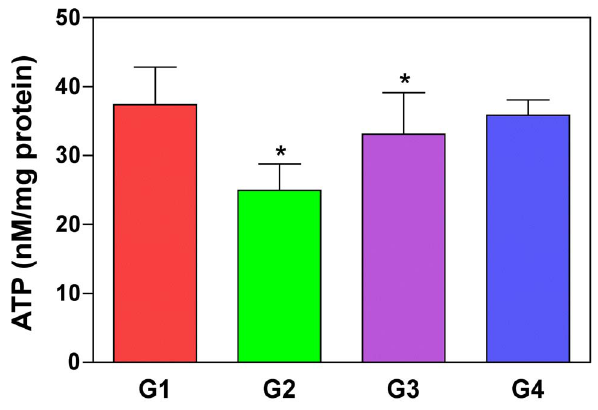
Figure 5. Oxalate-induced ATP depletion restored by C- phycocyanin pre-treatment in cells. ATP levels in cultured MDCK cells were significantly lowered when incubated with oxalate alone (G2) than control group (G1) (P=0.02). ATP depletion was significantly restored when cells were pre-treated with CP under oxalate-induced conditions (G3) (P=0.012). *G2 compared with G1; G3 compared with G2. P , 0.05 were considered significant. G1: Control; G2: Oxalate; G3: Oxalate + CP; G4: CP alone.